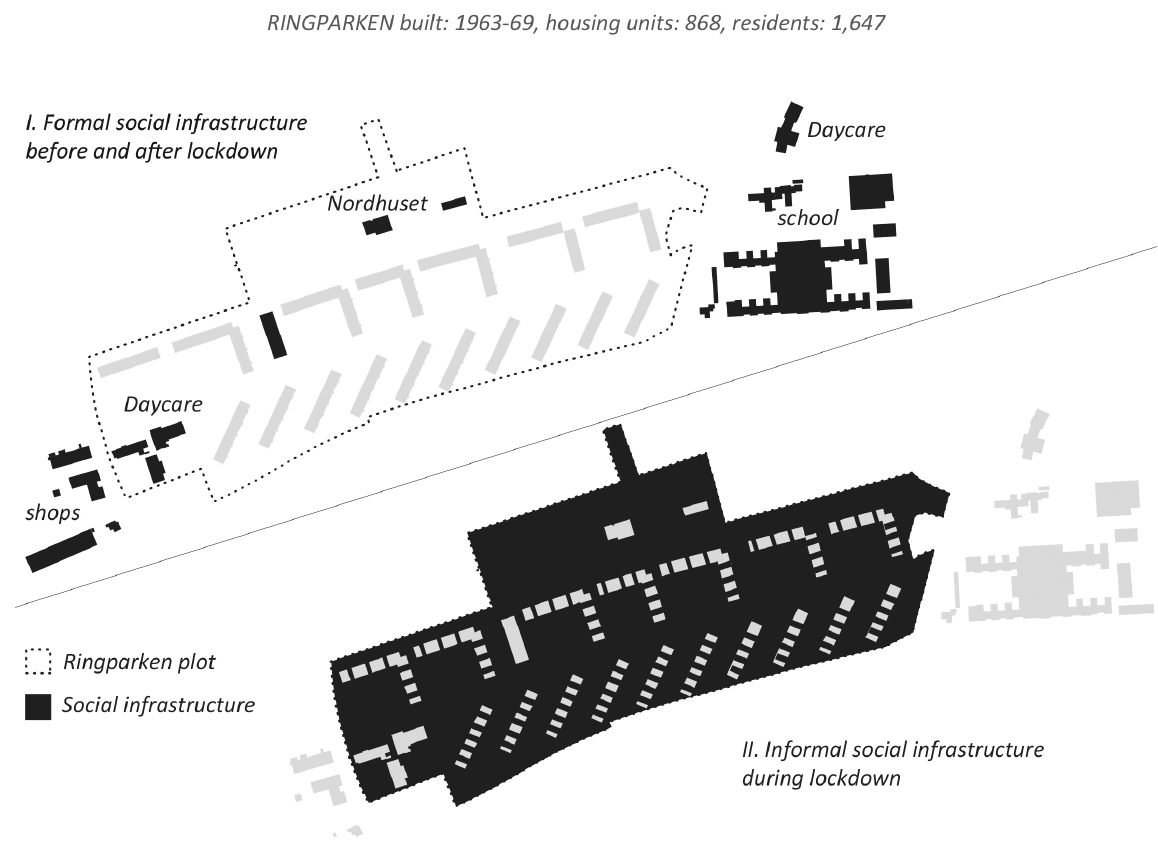
Figure 1. Social infrastructure before/after (I) and during the lockdown (II) in Ringparken. other formal meeting places in and around Ringparken closed, and organised social activities were